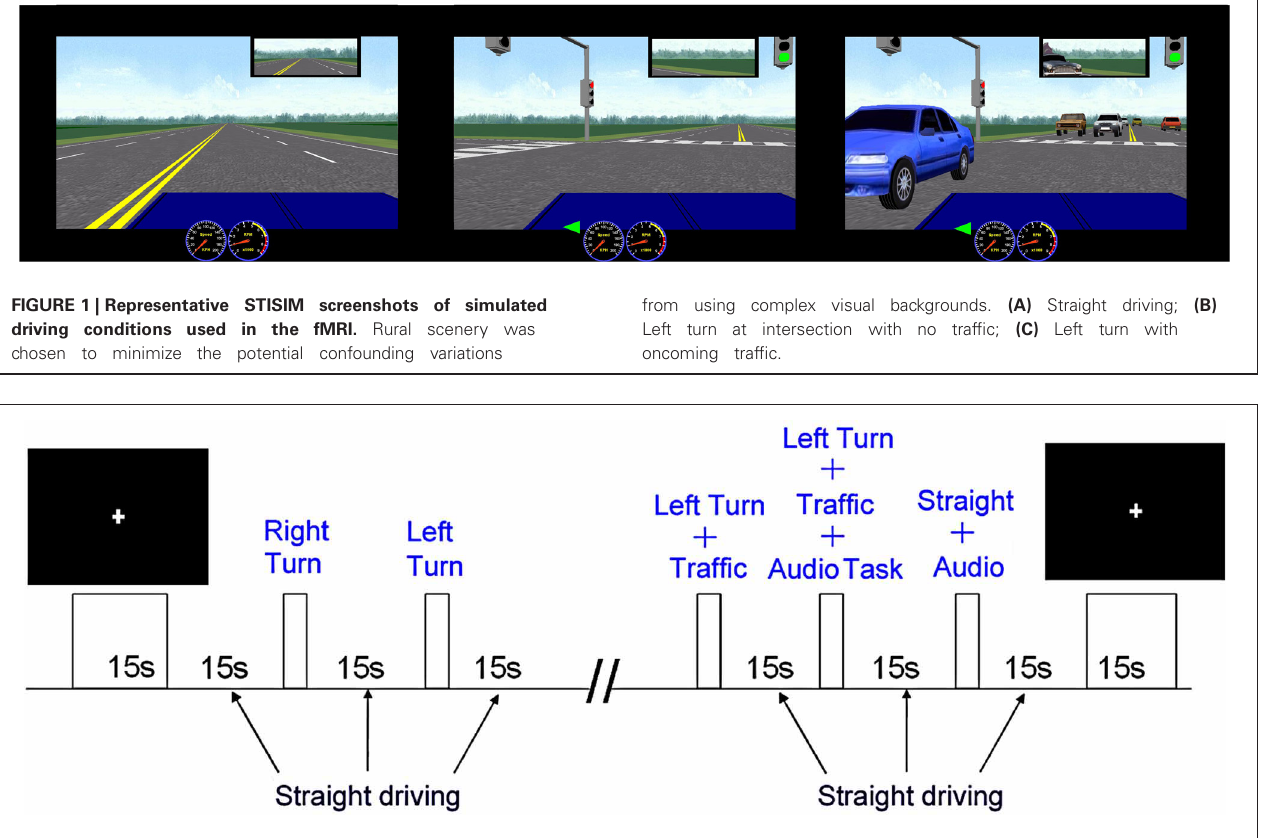
FIGURE 2 | The experimental task